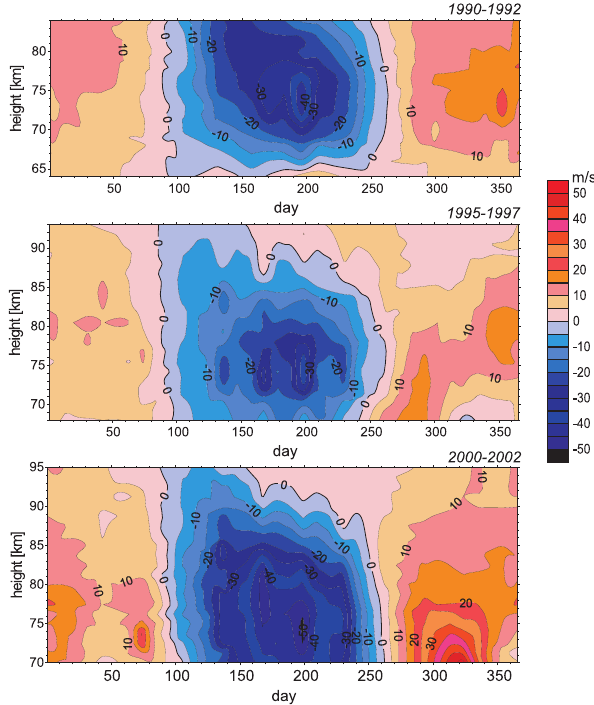
Fig. 3. Mean height-time cross section of the zonal wind for three different time intervals derived from MF-radar data at